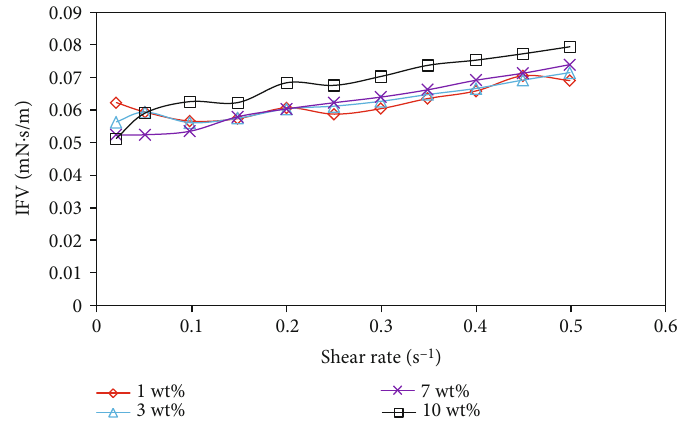
Figure 7: In fl uence of the resin content on